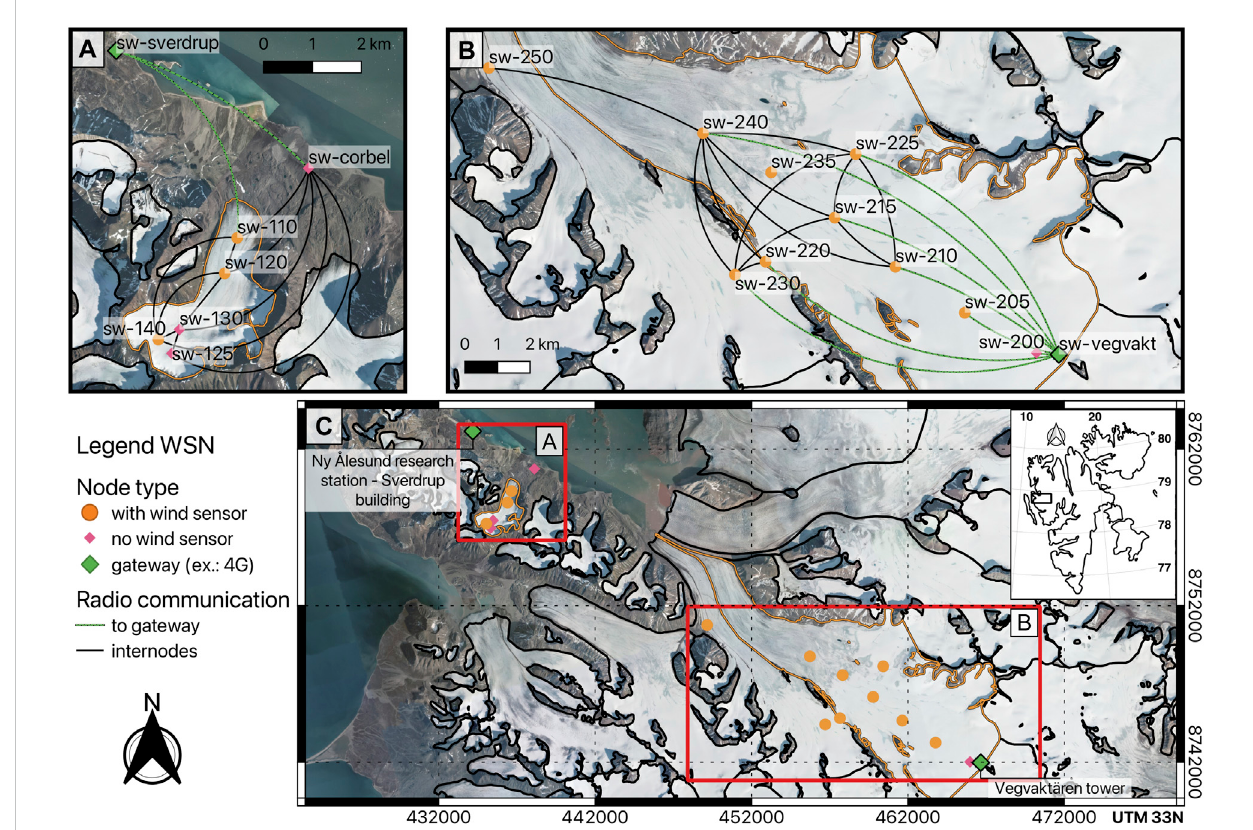
FIGURE 5 Map of the two networks deployed on the glaciers Midtre Lovénbreen (MLB) and Kongsvegen (KNG). MLB nodes send data either to the relay sw- corbel, or directly to an ethernet gateway installed at the Sverdrup research station (A) . KNG nodes send data to a 4G gateway located at the top of the glacier connecting the GSM network from Longyearbyen (B) . Lines in green indicate direct links node-gateway, and blue lines indicate node-node links. View of the two networks (C)